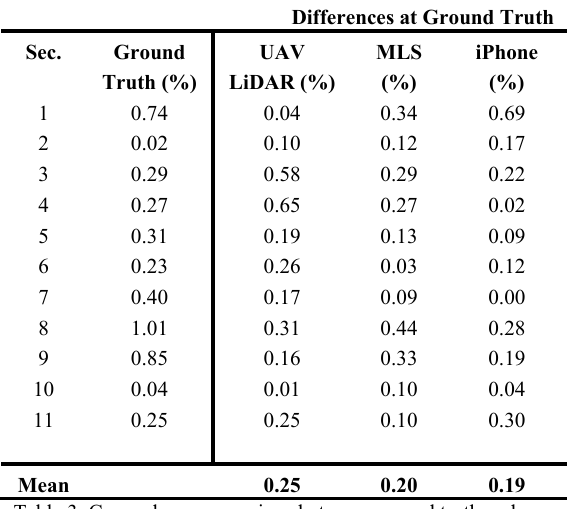
Table 3. Cross-slope comparison between ground truth and UAV-LiDAR, MLS, and iPhone The cross-slope evaluation results indicate that the average difference values obtained by all three methods were close to the acceptable limit of 0.2%, including the data obtained by the iPhone 14 Pro with the viDoc RTK